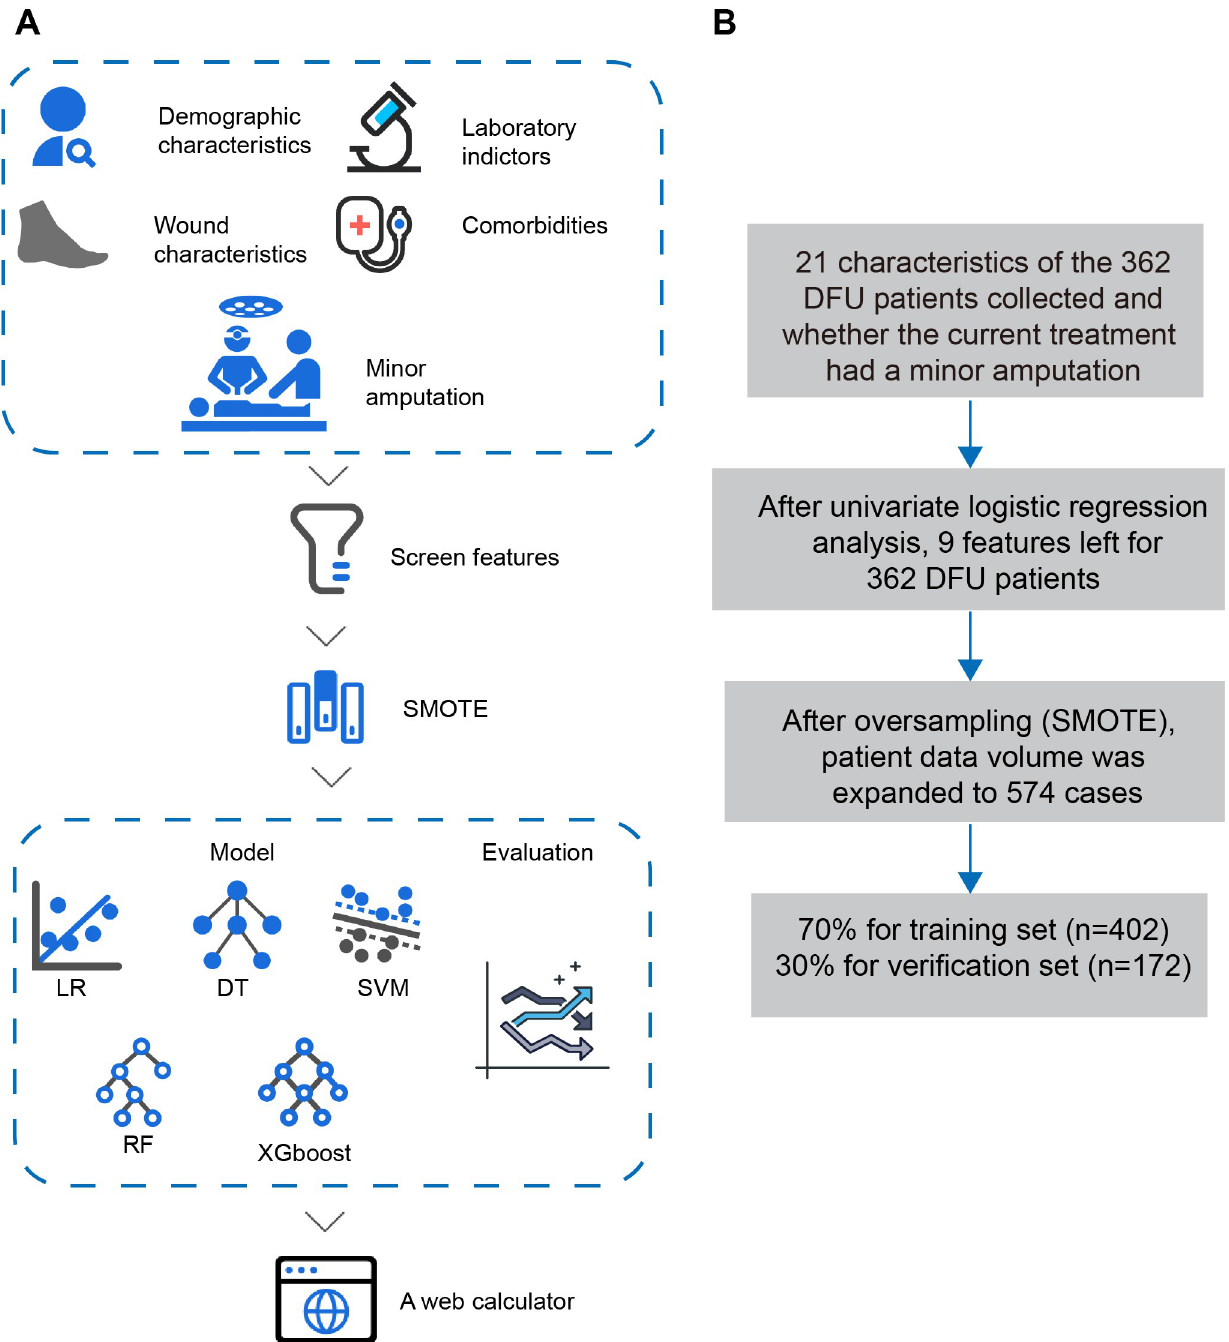
Fig 1. Study design flowchart and data screening flowchart. (A) Study design flowchart; (B) Data screening flowchart. Abbreviations : DFU, diabetic foot ulcer; DT, decision tree; LR, logistic regression; RF, random forest; SMOTE, synthetic minority oversampling technique; SVM, support vector machine; XGBoost, extreme gradient